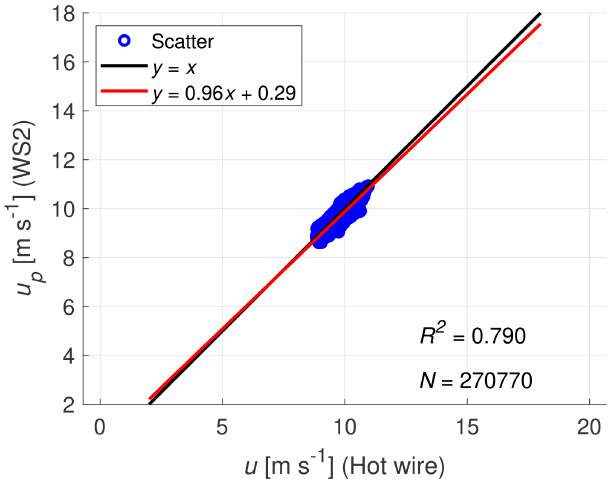
Figure 9. Correlation between WindScanner 2 and the hot-wire anemometer for a turbulence intensity of 3% (Case 1a).